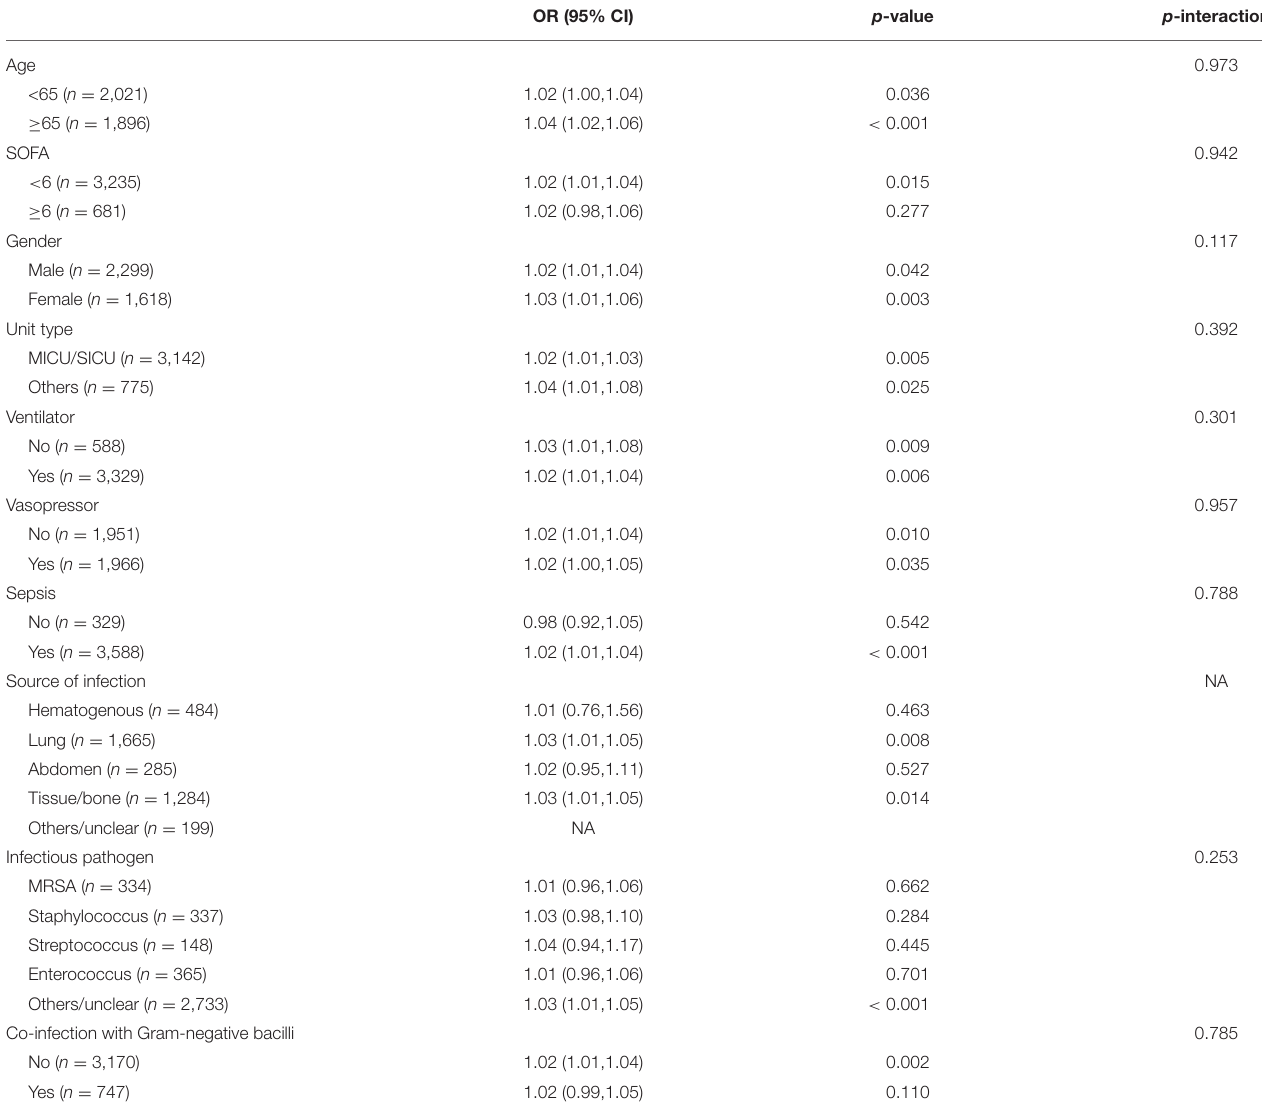
TABLE 3 | Subgroup analysis of the associations between the occurs of AKI and vancomycin trough concentration (continuous